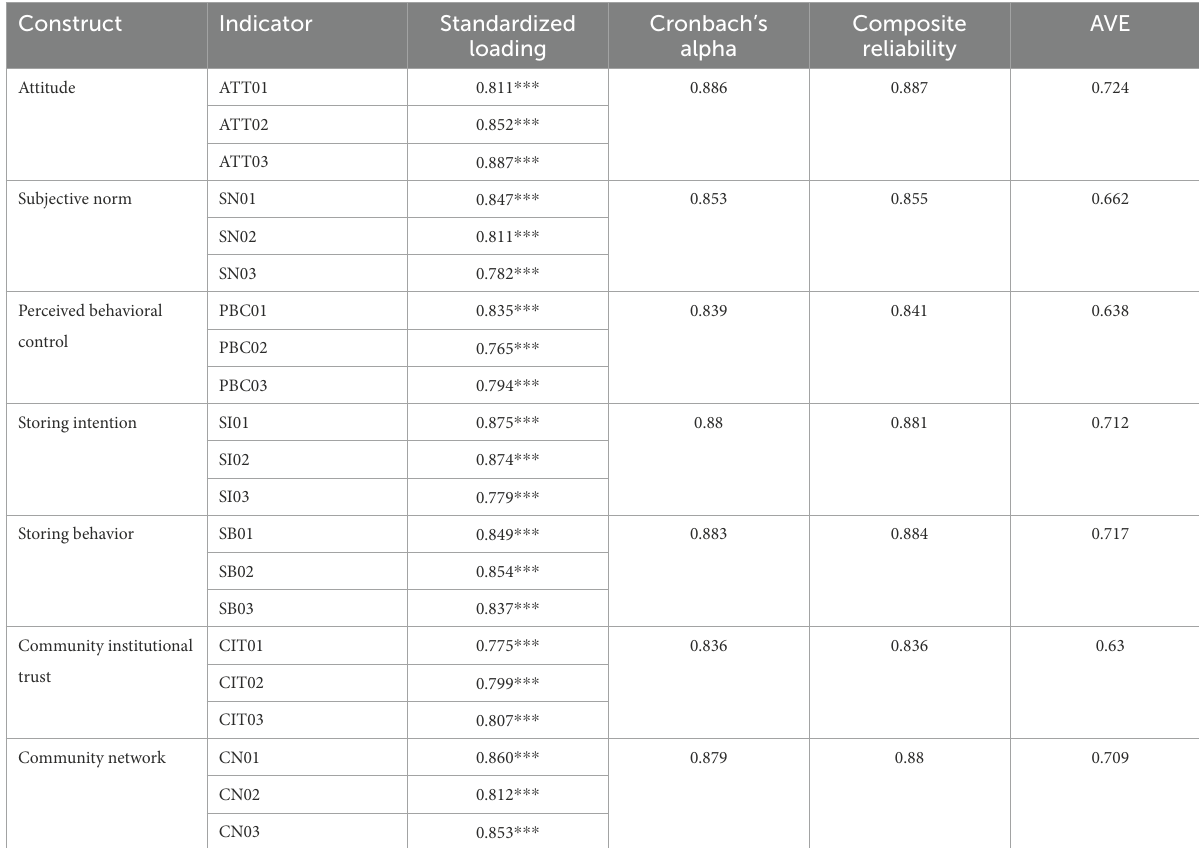
TABLE 2 Confirmatory factor